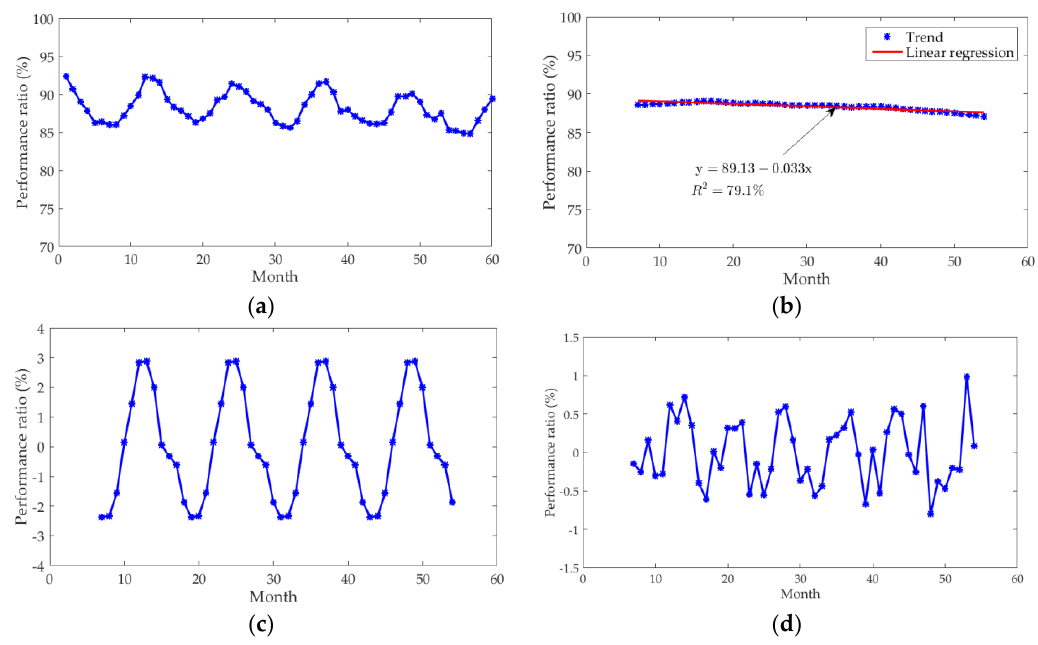
Figure 9. Classical times series decomposition of the monthly PR: ( a ) original signal; ( b ) component of trend and its linear regression line; ( c ) component of seasonality; ( d ) component of irregularity.